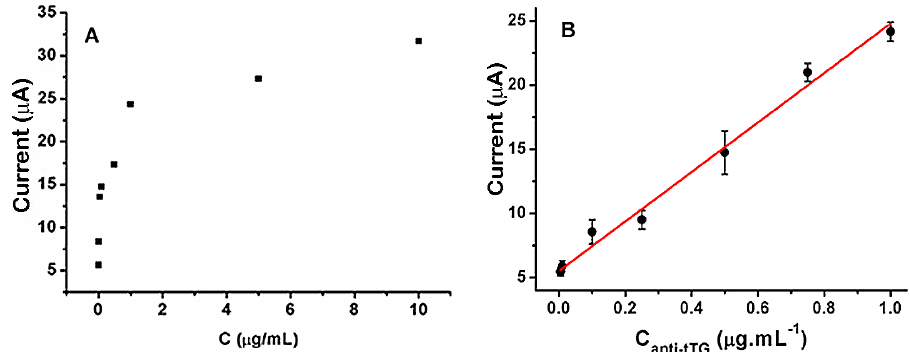
Figure 6. Dependence of the voltammetric current at − 0.35 V on the anti-tTG concentration: ( A ) 0.00–10 µg mL − 1 ; ( B ) 0.005–1.0 µg mL − 1 . Error bars indicate standard deviations of triplicate measurements ( n = 3).